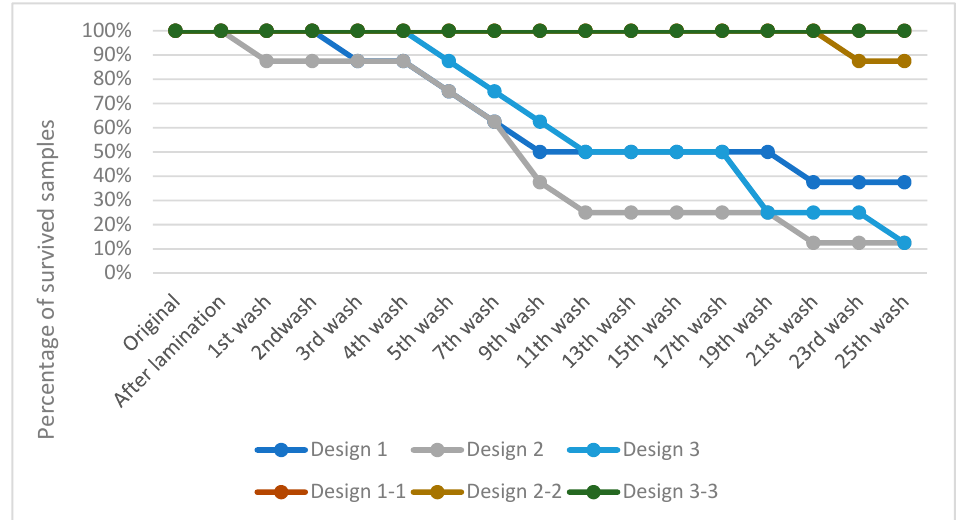
Figure 7. Survival graph of the experiments, per meander style. Design 1-1 and Design 3-3 overlap.